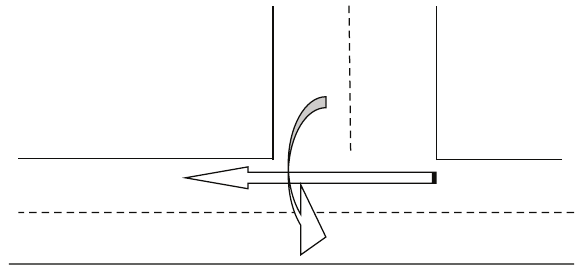
Figure 2: A “two-phase